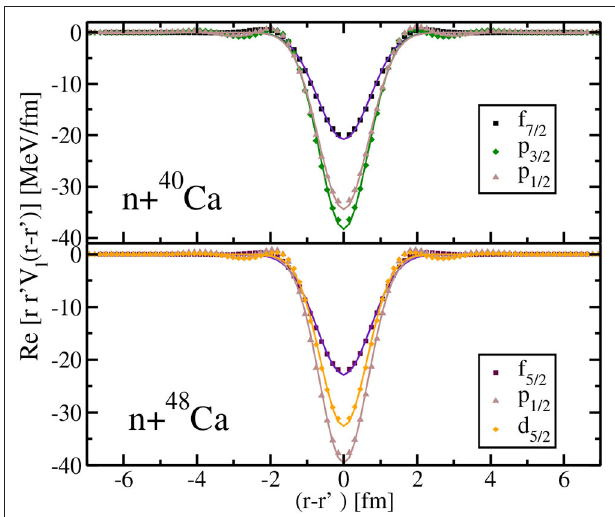
FIGURE 4 | Real part of the neutron potential in several partial waves for 40,48 Ca at respectively 5.2 and 7.8 MeV. The potentials are shown at fixed values of R (equal to the charge radius in both nuclei) and as a function of r − r ′ . Symbols corresponds to the calculated potentials and the lines are the results of a fit with a Gaussian form factor (see text for